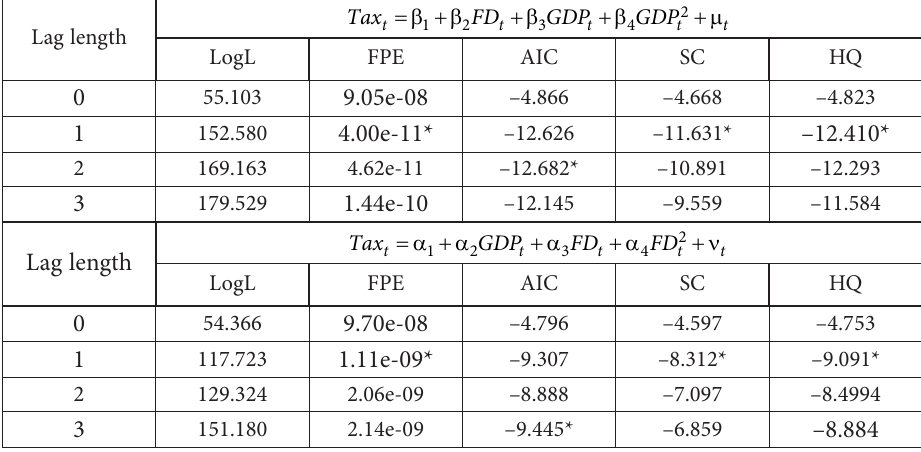
Table 4. Lag length selection